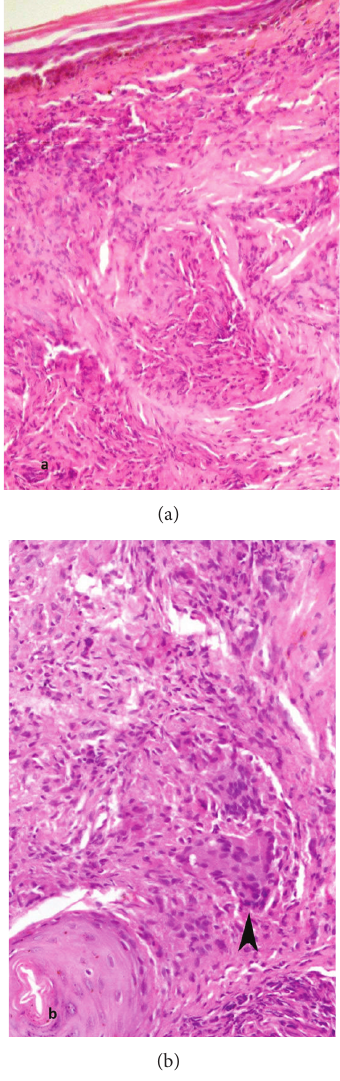
Figure 4: Skin biopsy shows numerous well-circumscribed, non- caseatingepithelioidgranulomasinthedermis(a)(hematoxylinand eosin, × 200). Few multinucleated giant cells are also seen in the granulomas (b) (arrow head, hematoxylin and eosin, ×